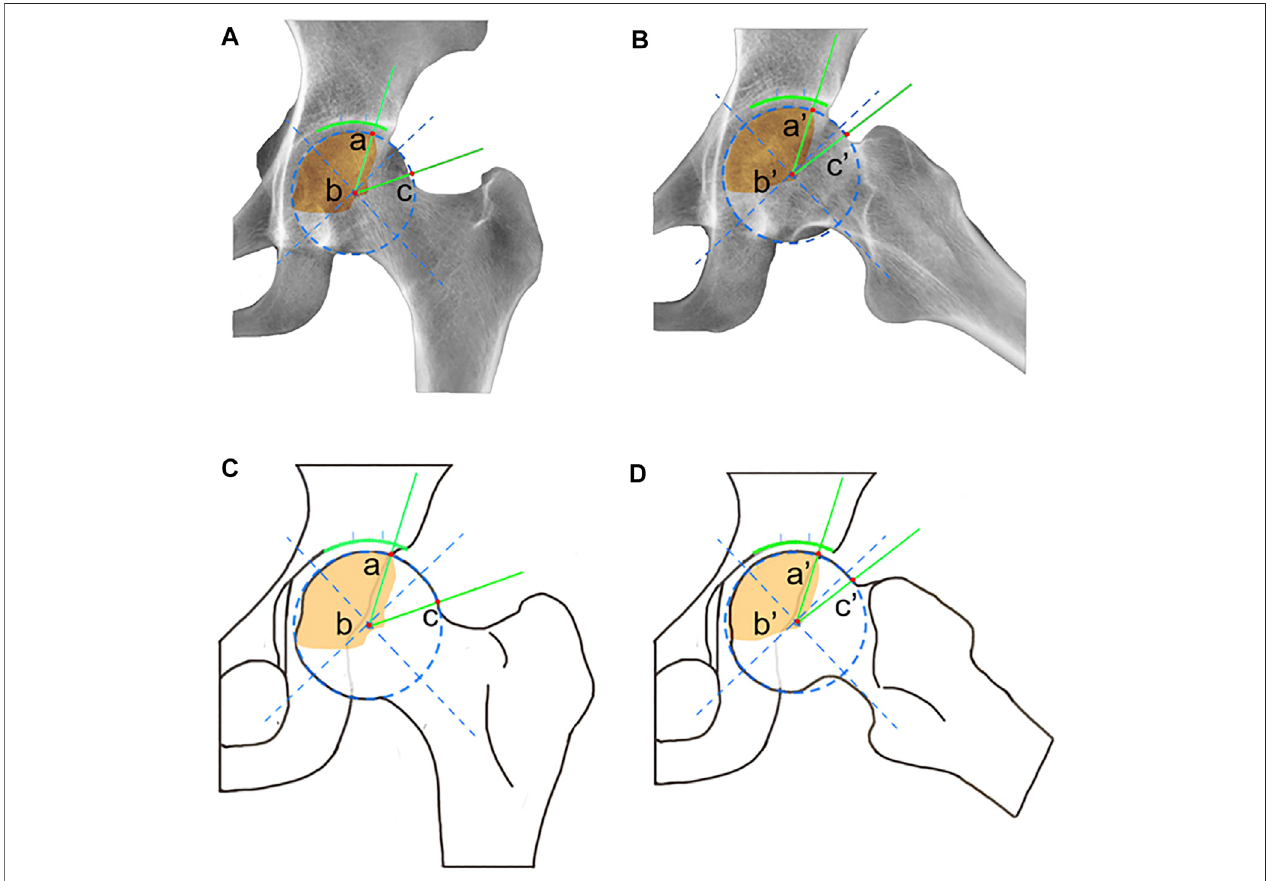
FIGURE 4 | Schematic diagram of LPA, APA, and CPA. (A) For LPA measured in AP radiographs, point a is the intersection of necrotic area and the edge of the femoral head, point b is the center of the femoral head, and point c is the junction of the femoral head and the femoral neck. The unit of LPA is degrees, and the LPA rangesfrom0to180 ° . (B) ForAPAmeasuredinFLLradiographs,pointa ′ istheintersectionofthenecroticareaandtheedgeofthefemoralhead,pointb ′ isthecenterof thefemoralhead,andpointc ′ isthejunctionofthefemoralheadandthefemoralneck.TheunitofAPAisdegrees,andtheAPArangesfrom0to180 ° .CPAequalto the sum of LPA and